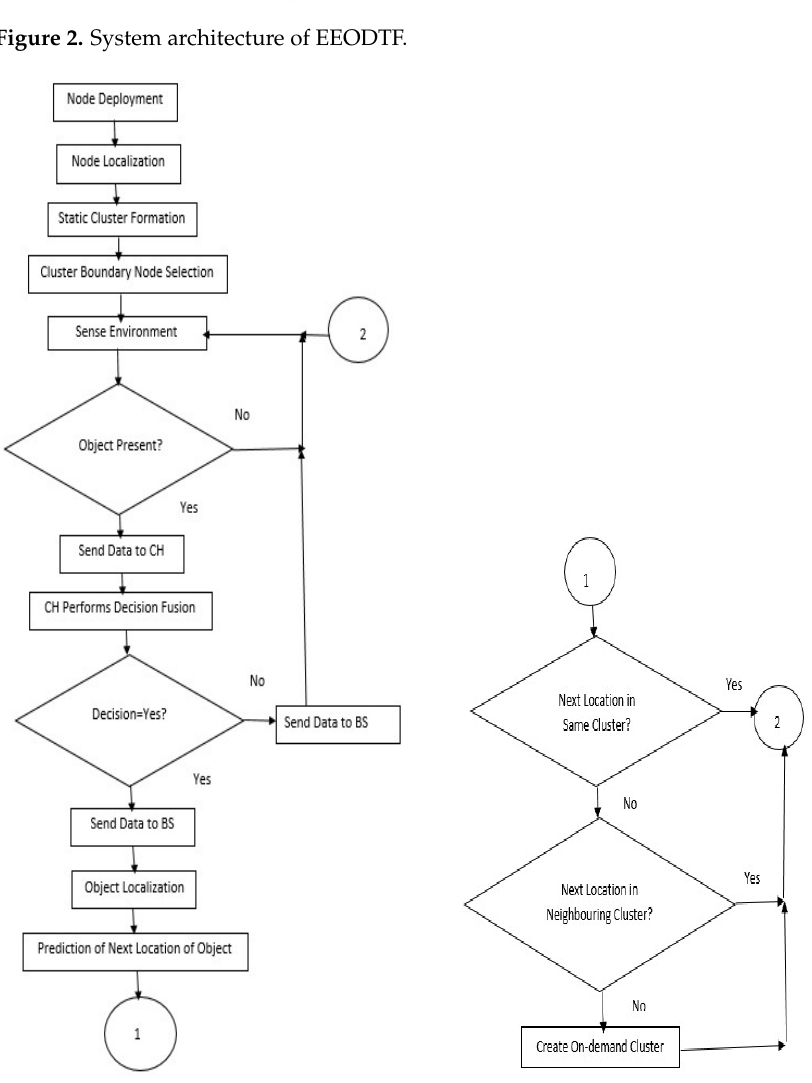
Figure 3. System flow chart of EEODTF.